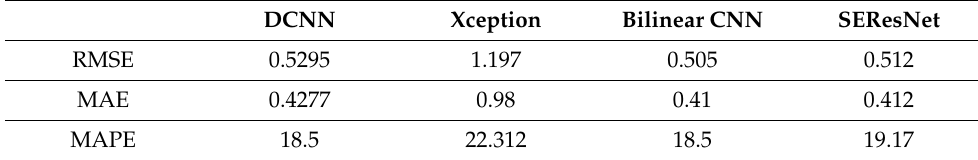
Table 12. Model prediction average